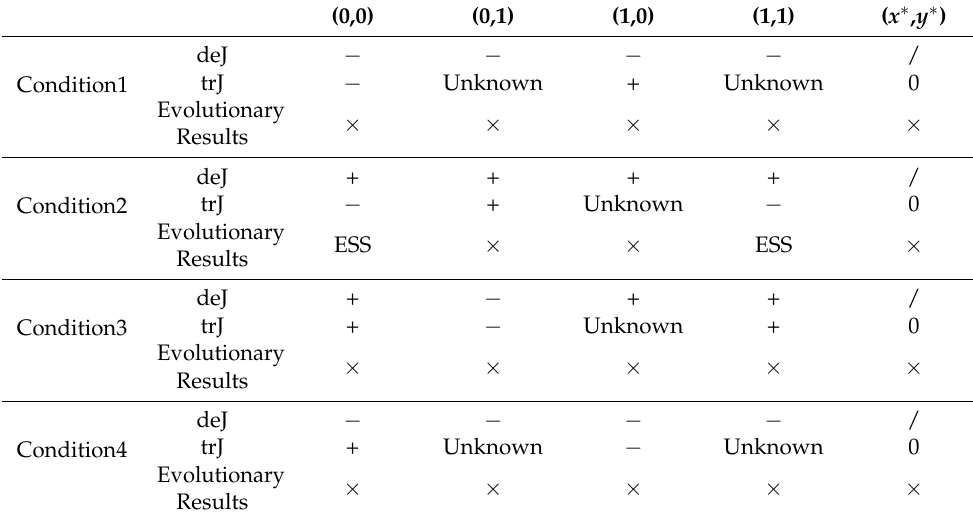
Table 3. Analysis of equilibrium point